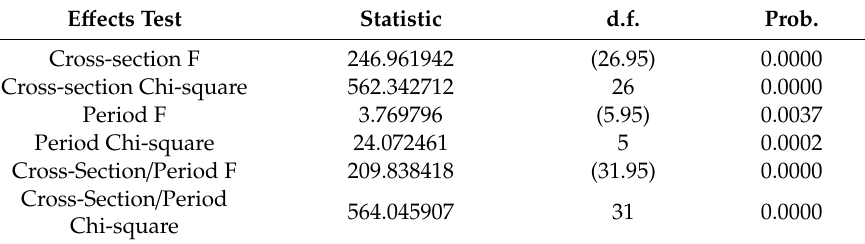
Table 7. Results of the redundant fixed e ff ects